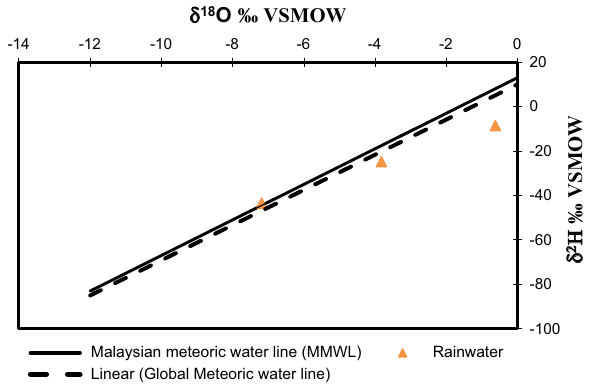
Fig. 4 Plot of δ 2 H versus δ 18 O for precipitation samples for wet and dry seasons. LMWL represents the local meteoric water